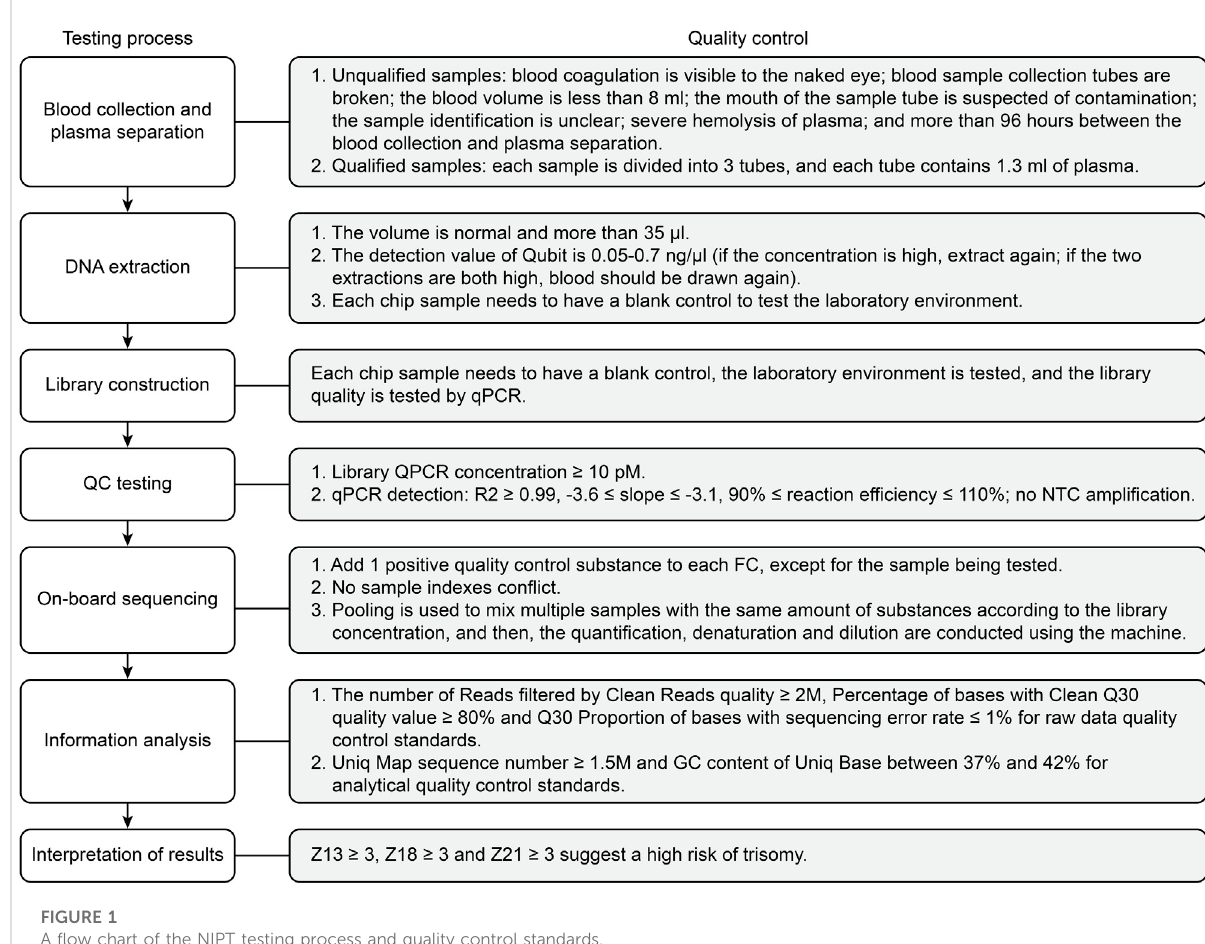
FIGURE 1 A fl ow chart of the NIPT testing process and quality control